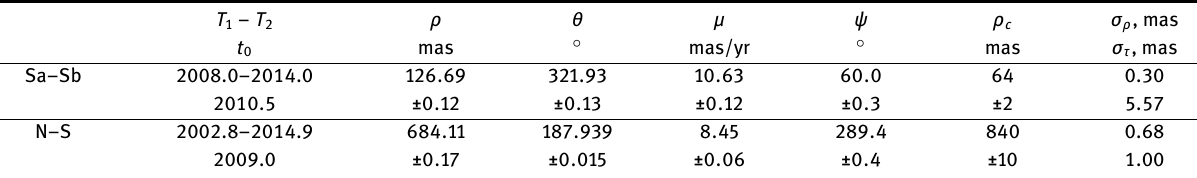
Table 2. The star T Tauri. The Apparent Motion Parameters.